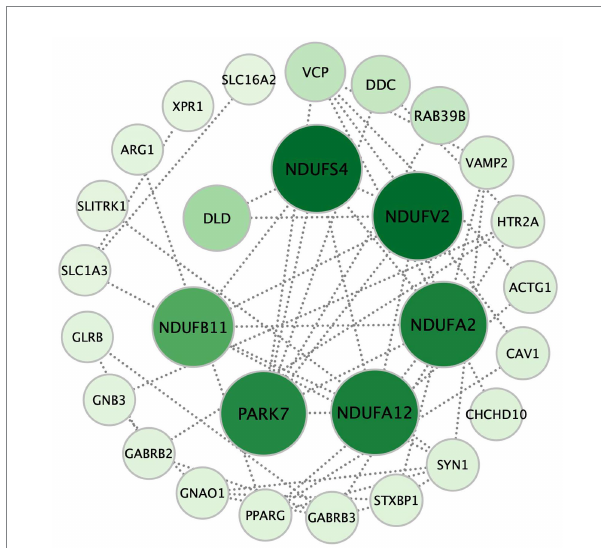
FIGURE 3 The seven hub genes of the retrograde eCB signaling pathway in patients with MDD based on the PPI analysis. Each circle represents a gene variation, and the sizes and color densities of each circle reflect ranking based on eigenvector centrality (EC). Larger, darker circles indicate the genes that are more significantly enriched in this pathway. The top seven most important genes are in the inner circle, while the others are arranged in the outer circle. eCB: endocannabinoid; PPI: protein–protein